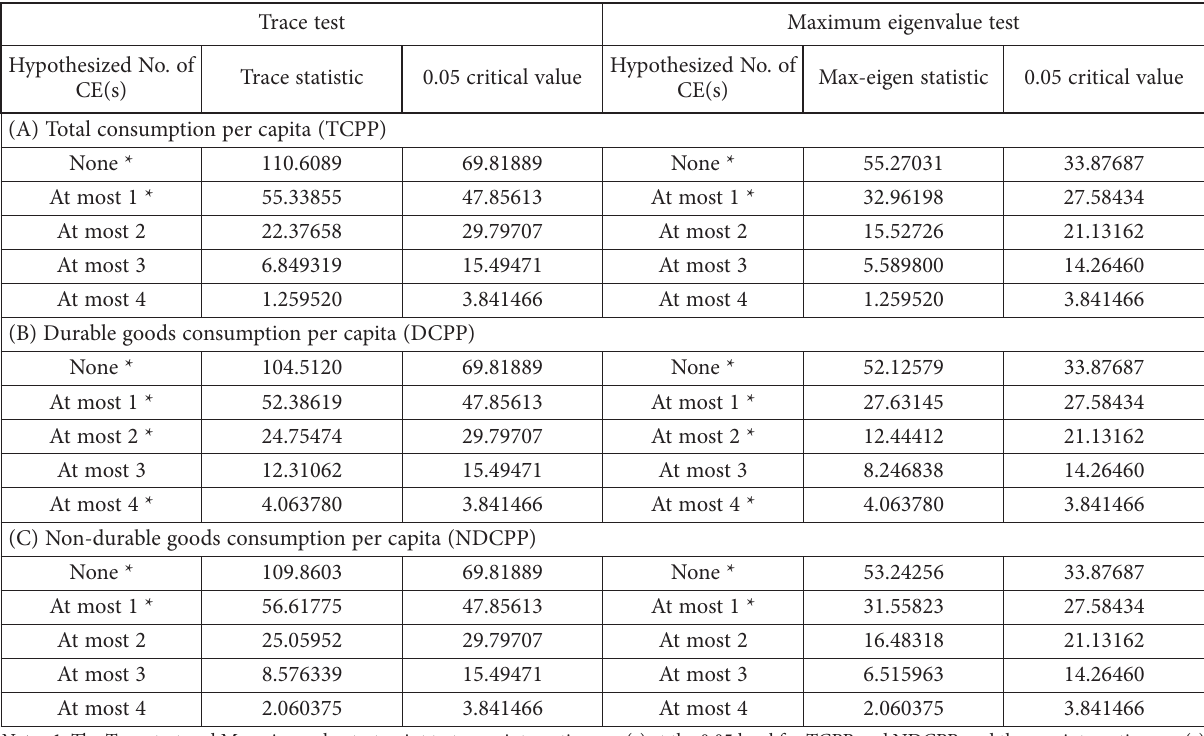
Table 5. Johansen test for cointegration for main categories of